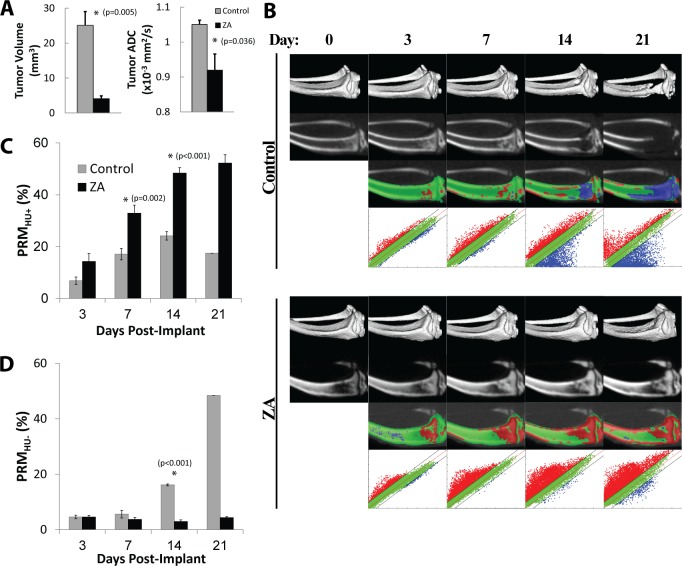
PC3 implantations treated with zoledronic acid (ZA, n = 4) show a bone-protective effect compared to controls (n = 8).(A) MRI tumor volume and ADC determined at day 21 post-treatment-initiation shows a retardation of tumor growth and significantly lower ADC in the zoledronic acid treated animals. (B) PRMHU+ bar plot shows significantly higher volume of bone that increased in density after treatment compared to controls. (C) PRMHU- bar plot shows minimal loss of bone in the ZA-treated group, compared to progressively increasing bone loss in the controls. (D) Representative images for a control (top) and ZA-treated (bottom) mouse showing (from top to bottom) an isosurface, CT slice, PRM overlay, and PRM scatterplot from pre-treatment to 21 days post-treatment.